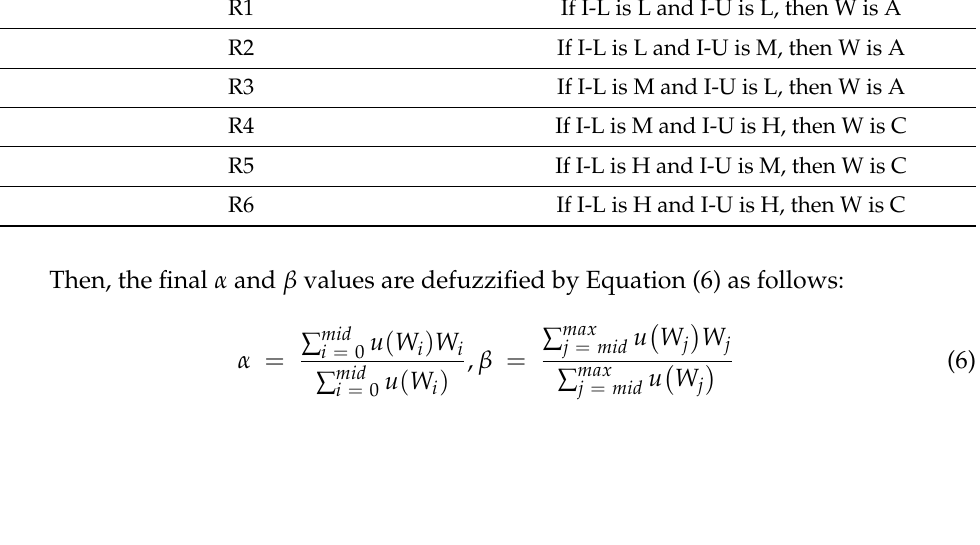
Figure 3. Fuzzy output membership functions for lower and upper limit. ( a ) Lower limit, ( b ) Upper limit. Table 1. Fuzzy inference rules for fuzzy stretching.